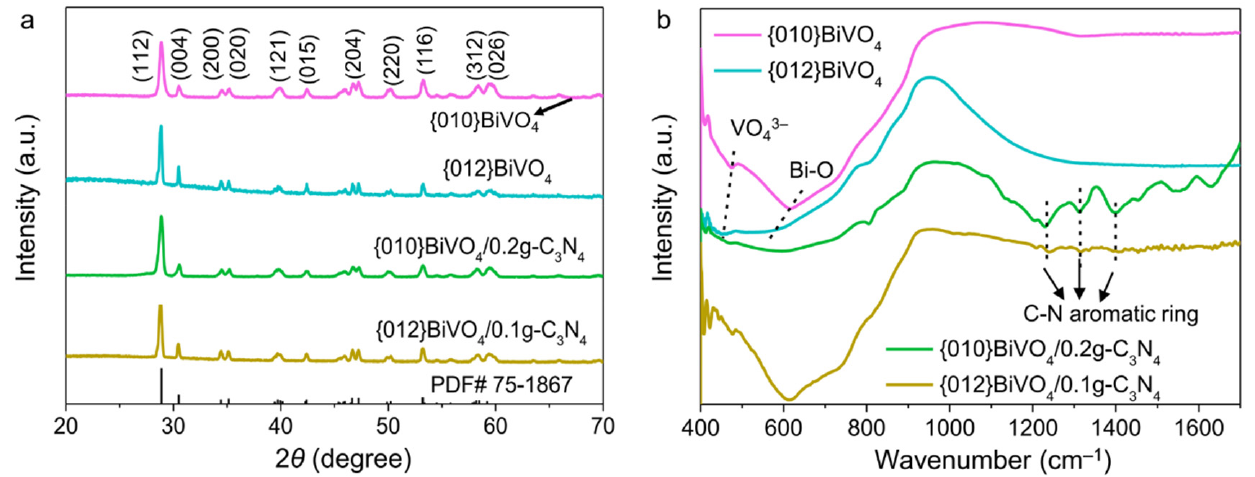
Figure 2. ( a ) XRD patterns and ( b ) FTIR spectra of {010}BiVO 4 , {012}BiVO 4 , {010}BiVO 4 /0.2g-C 3 N 4 , and {012}BiVO 4 /0.1g-C 3 N 4 .